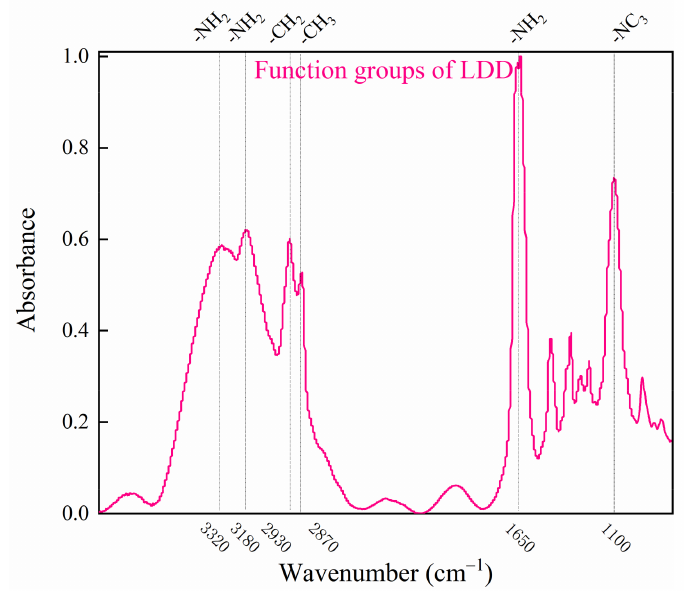
Figure 2. FTIR spectrum of LDD.